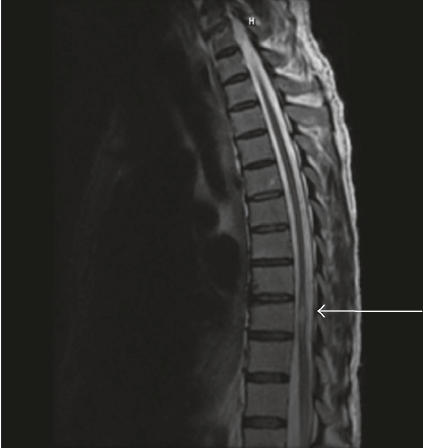
Figure 2: Focal area of abnormal signaling with nonenhancement at the level of